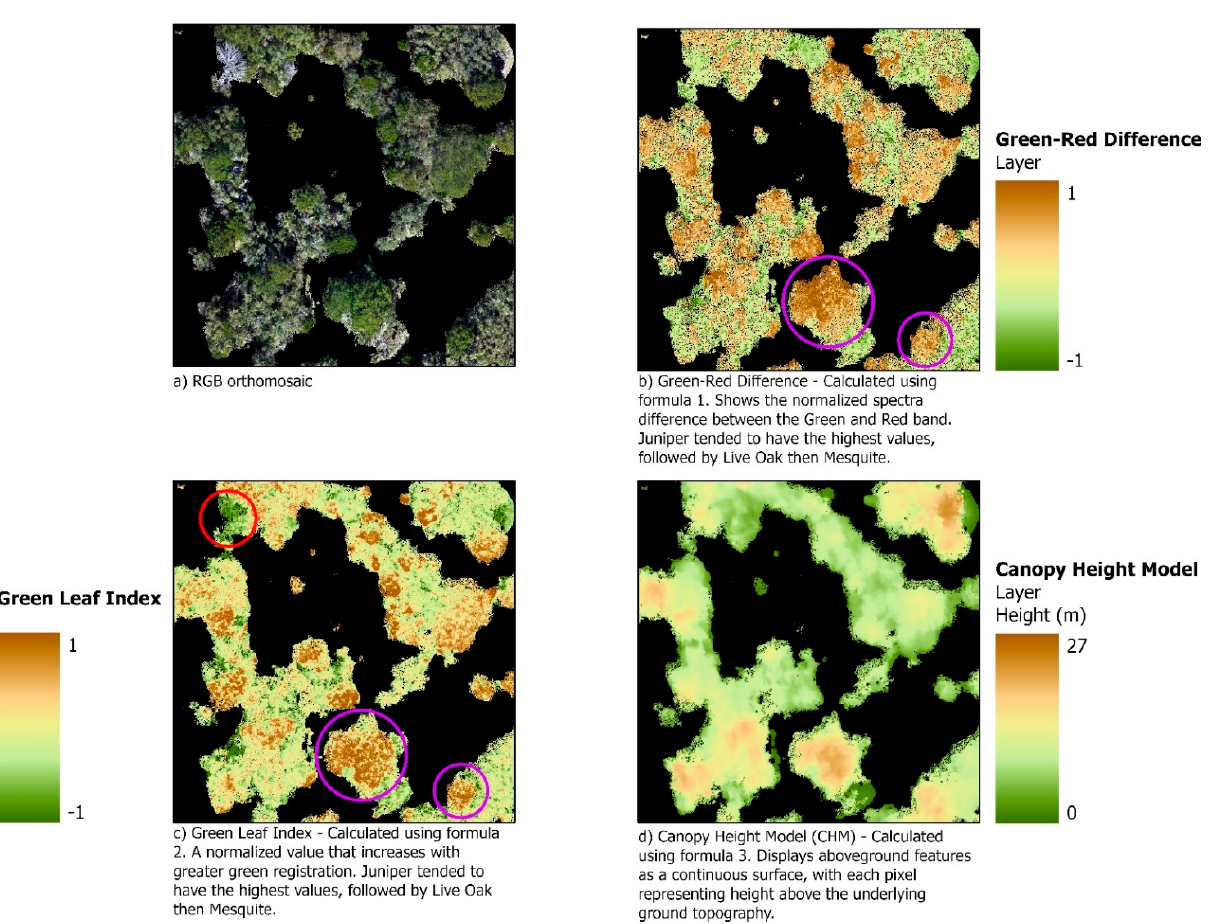
Figure 3. The 3 data layers created to improve the traditional and classical machine learning classifications. ( a ) The 10 cm orthomosaic. ( b ) The Green-Red Difference layer only discerns junipers (displayed as dark brown). ( c ) The Green Leaf Index layer is able to discern the mesquites (displayed as dark green) and the juniper (displayed as brown). ( d ) The Canopy Height Model layer discerns the tops of individual woody plants with lighter green/brown and the edges of tree canopies as darker green.